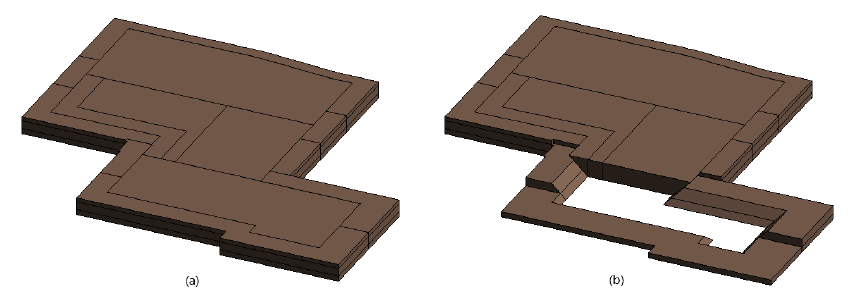
Figure 6. Construction site virtual twin ( a ) before updating, ( b ) after updating.